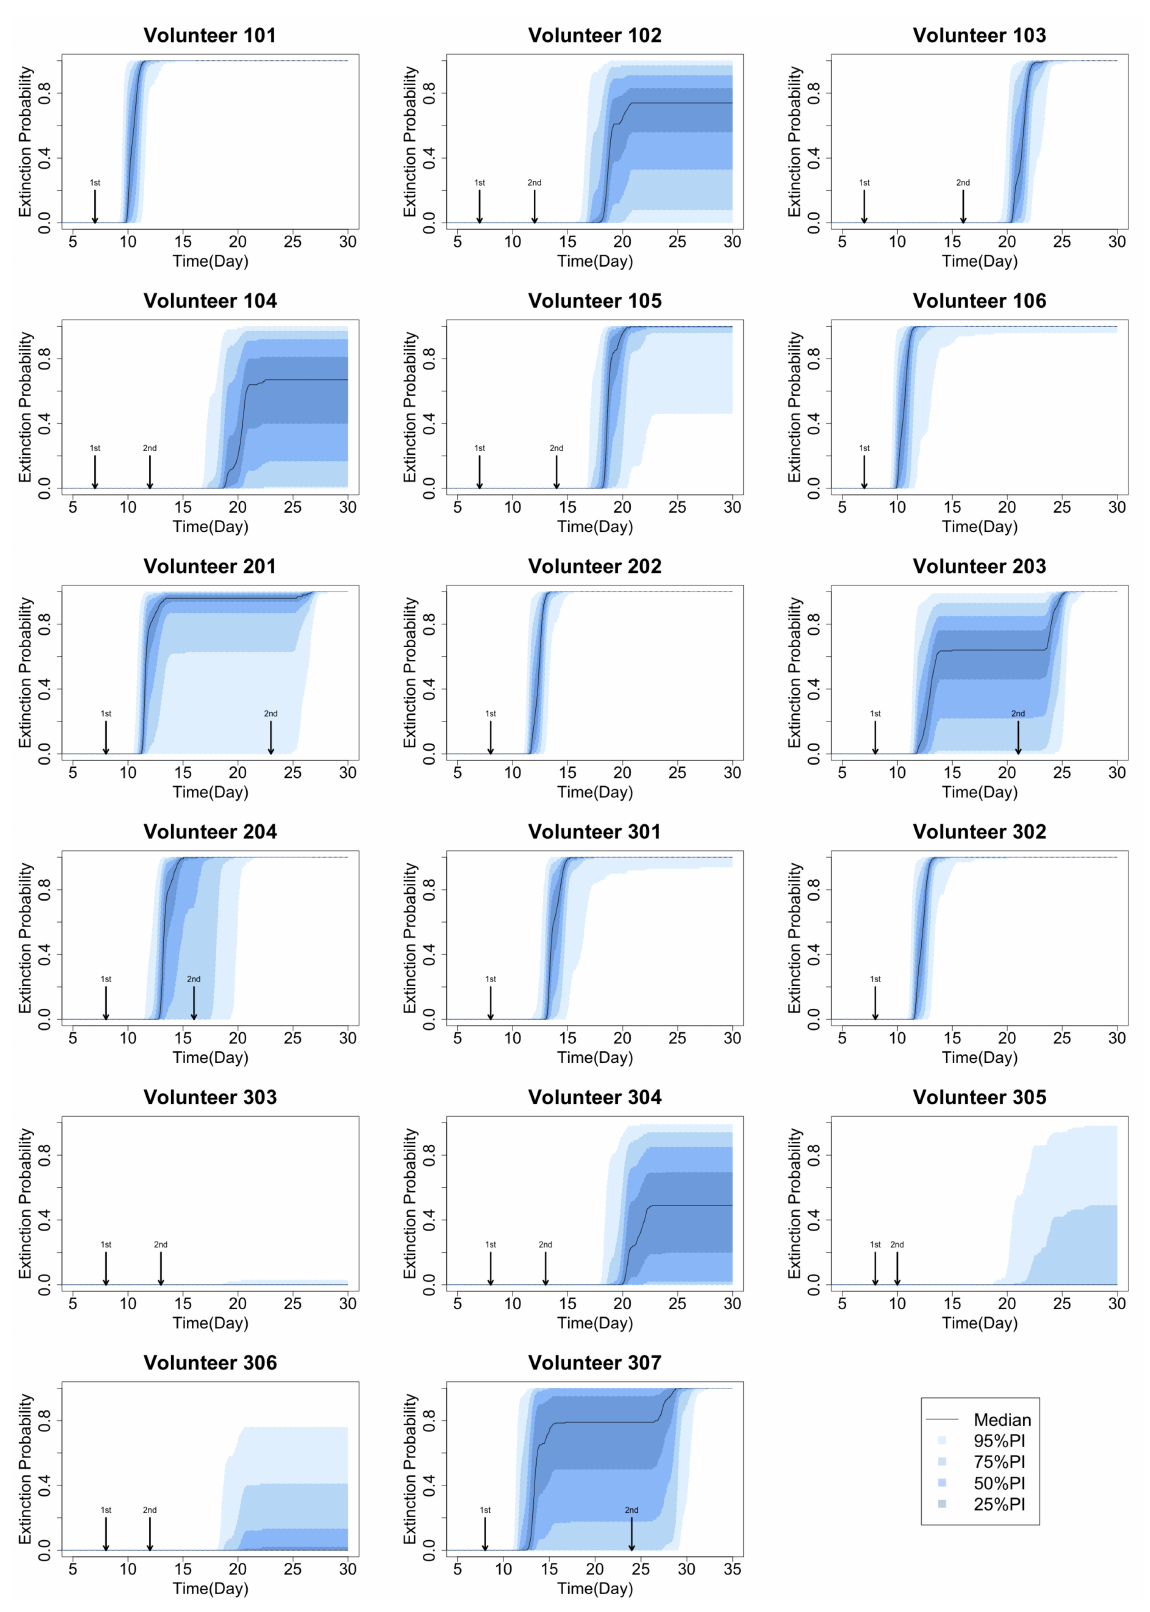
Figure A1. The extinction probability over time after treatment for all 17